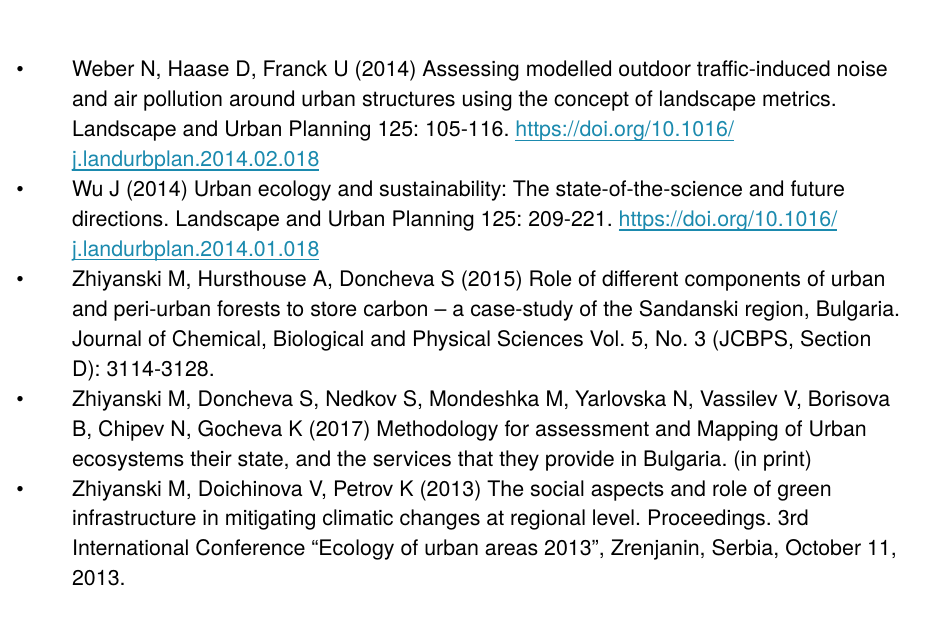
Brief description: Figure representing examples of catalogues used during the identi fi cation built and land cover types.